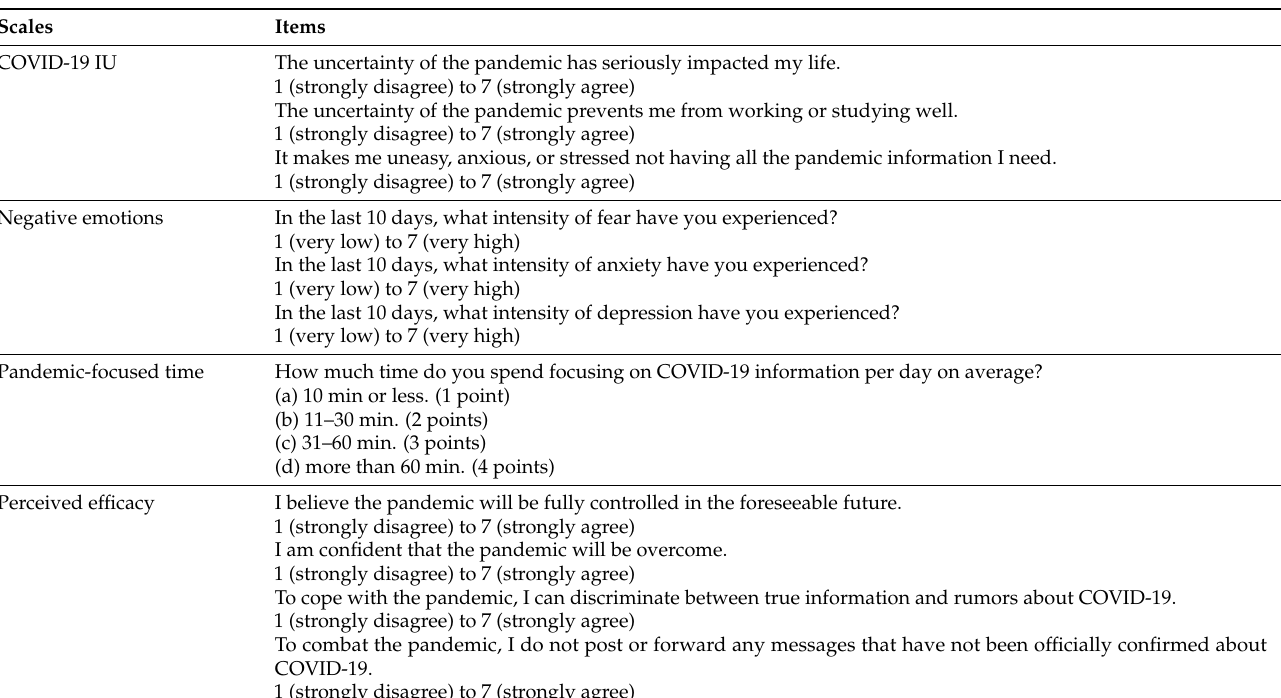
Table A1. Survey on